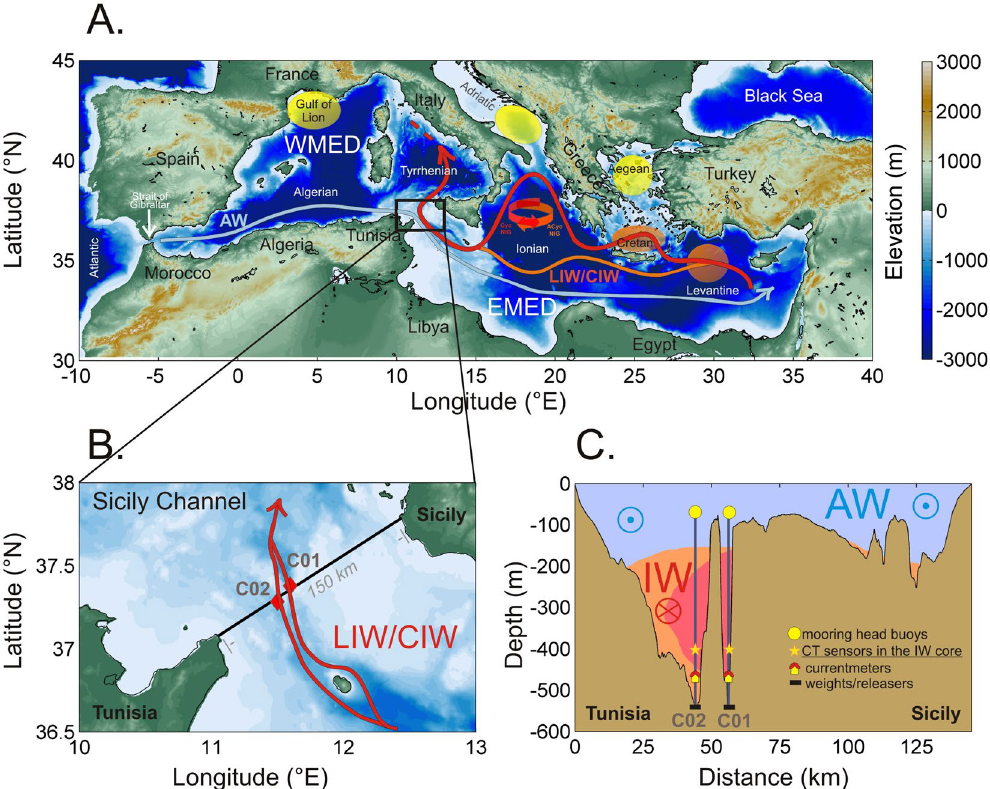
Figure 1. ( A ) The Mediterranean Sea where deep (yellowish ellipses) and intermediate (reddish ellipses) water formation sites are highlighted as well as the circulation schemes for the Atlantic Water (AW, light blue arrow) and the Levantine/Cretan Intermediate Waters (LIW/CIW, red arrow), the black rectangle indicates the monitored area; ( B ) zoom on the Sicily Channel where the positions of the two moorings (C01 and C02) are shown (red diamonds), that allow both branches of the bifurcated LIW/CIW flow (red arrow) to be intercepted; ( C ) vertical schematic section of the 150 km-long transect between Tunisia and Sicily (black line in ( B )), showing the two-layer system of water masses flowing in opposite directions (AW in light blue flowing eastward; IW in orange flowing westward, where the darker orange indicates higher salinity, the salinity maximum identifying the core of the IW) and the positions of instruments along the C01 and C02 lines located in two parallel deep trenches. The data discussed in the paper come from the conductivity-temperature sensors at about 400 m depth, located in the intermediate water (IW) (the yellow stars). Maps were generated by using MATLAB 7.1